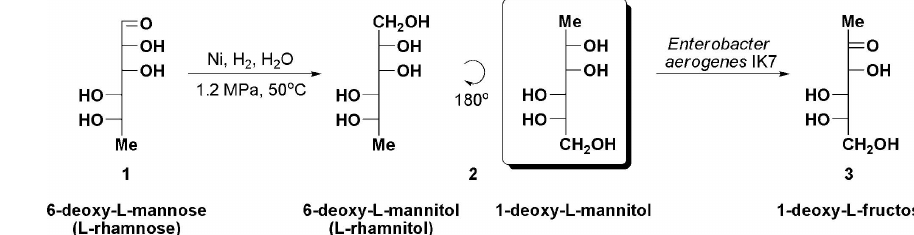
Synthetic scheme.